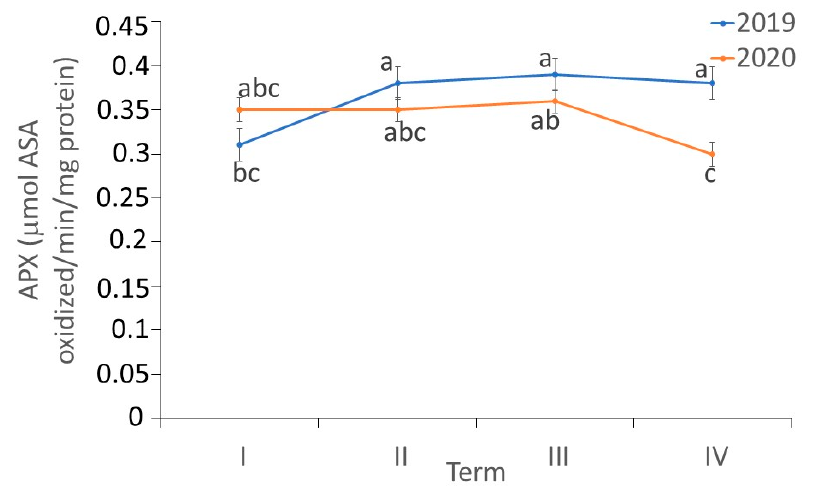
Figure 9. Changes in the APX activity ( µ mol ASA oxidized/min/mg protein) in A. fabae fundatrigeniae during feeding on V. opulus (means ± SD; n = 4). Different letters denote significant differences (one–way ANOVA; Tukey’s test; p < 0.05).